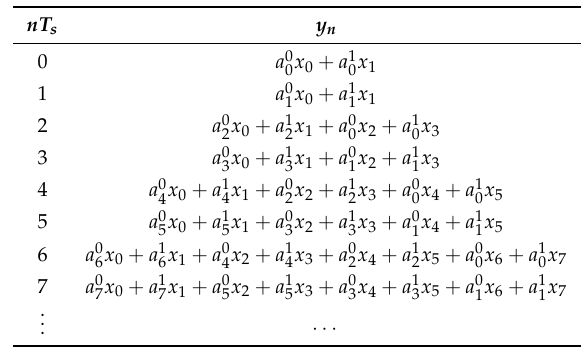
Table 2. Wavelet symbols produced by the encoder with 2 × 8 wavelet coefficient matrix (WCM) for k = 1.